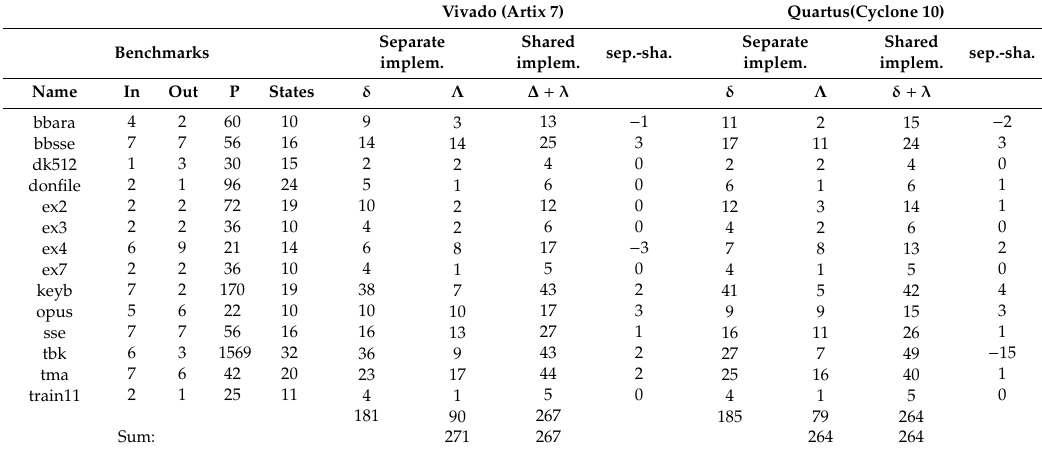
Table 6. Results of experiments (Vivado and Quartus II, number of states ≥ 10). Benchmarks